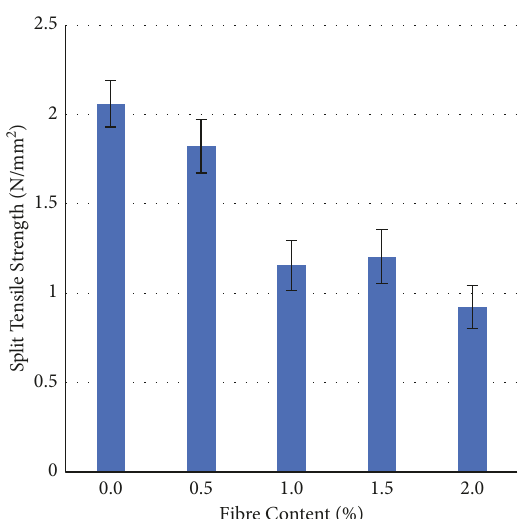
Figure 7: Effect of fibre addition on split tensile strength of FRCC.